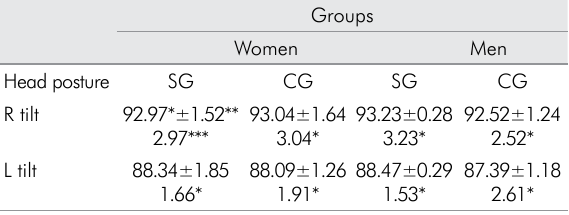
Table 5. Mean, standard deviation, and mean actual change of head tilt angle for men and women with and without